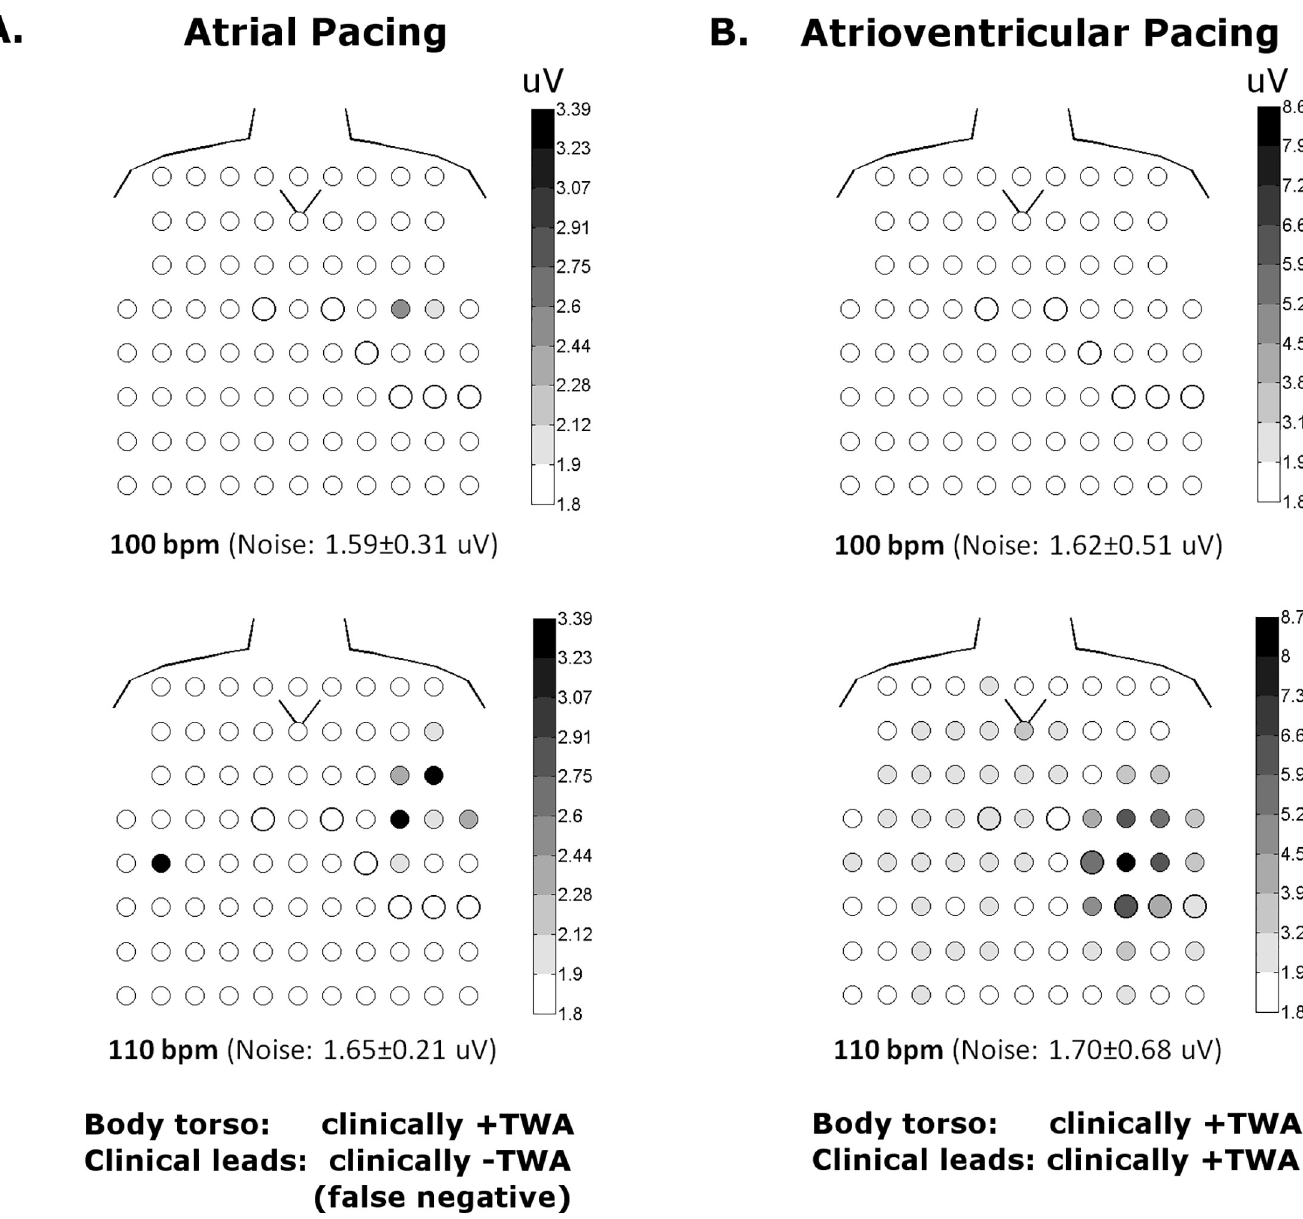
Fig 4. Body torso maps of V alt (uV) in one patient during atrial and atrioventricular pacing. The anterior torso with V1-V6 is indicated by the bold circles and the V symbol depicts the sternal notch. The posterior torso is not shown for simplicity as there is virtually no TWA signal. With atrial pacing ( A ), TWA is detected outside the clinical leads at 100 and 110 bpm. This patient would be classified as clinically–TWA using clinical leads, but +TWA with body torso mapping (i.e. false negative). With atrioventricular pacing ( B ), TWA is detected in body torso as well as clinical leads at 110, but not 100 bpm. Thus atrioventricular pacing would classify this patient as clinically +TWA using clinical leads, while atrial pacing resulted in a clinically negative test (i.e. false negative).